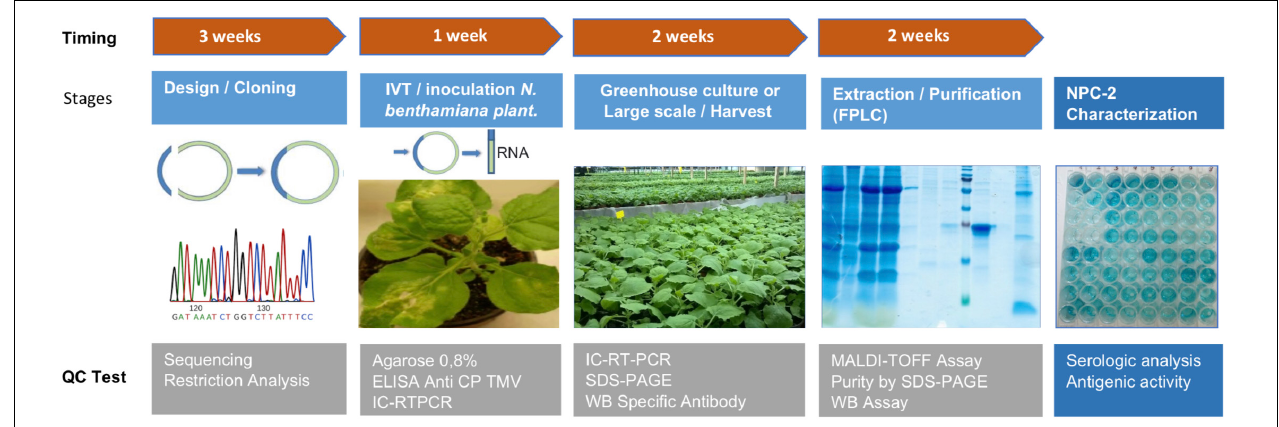
FIGURE 6 | Flowchart of the complete process of production of NPC-2 from N. benthamiana plants. The upper timeline describes the extent of different stages: Design/Cloning (3 weeks), in vitro transcription and production of inoculum (1 week), plant greenhouse culture of large scale (2 weeks), Extraction/Purification of final product NPC-2 from plants (2 weeks). The lower boxes show the quality control tests associated with each stage.